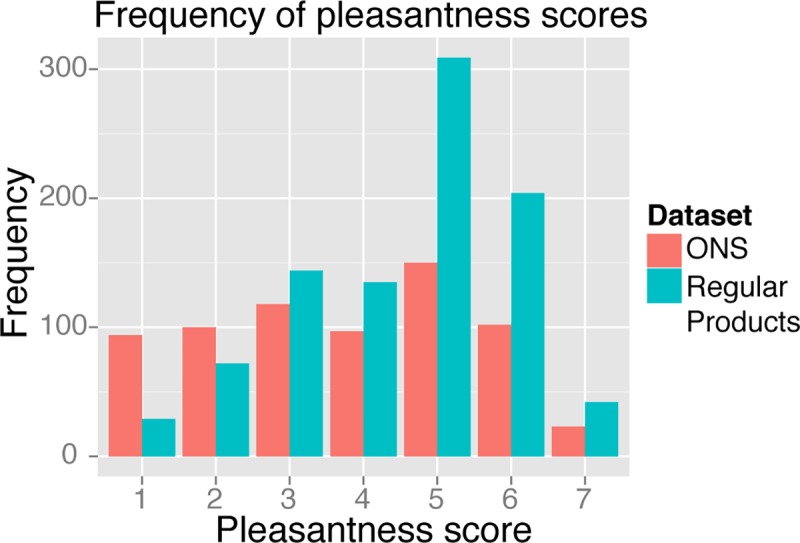
Flavor pleasantness scores.Histogram indicating the frequency of all pleasantness scores within the ONS (mean = 3.74, sd = 1.75) and regular products (mean = 4.5, sd = 1.45) data sets. Regular products received higher pleasantness scores (β = -0.75, T(37.58) = -3.61, P < 0.001).